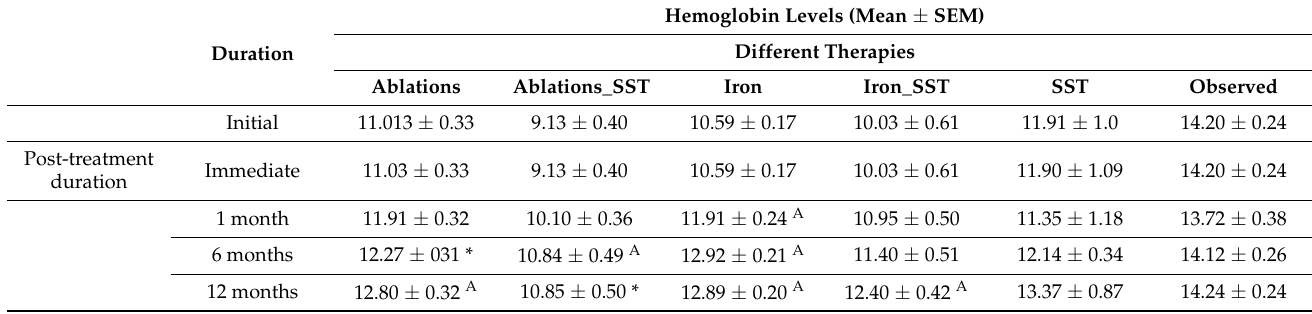
Table 2. Hemoglobin level recovery by different therapies at different time points post-treatment.